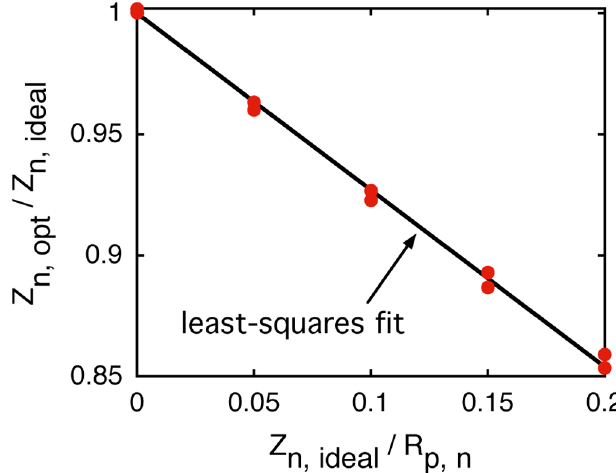
FIG. 9. (Color) The ratio Z n; opt =Z n; ideal as a function of =R Z Z n; ideal p;n . The quantity n; opt is the LTD-module output impedance that maximizes the peak forward-going electrical power produced by a module, when Eqs. (1), (2), and (10) are satisfied; Z n; ideal is the optimum impedance in the absence of magnetic-core losses. R p;n is the effective parallel resistance of an LTD cavity module, and is included in the circuit model to account for energy loss to the module’s magnetic